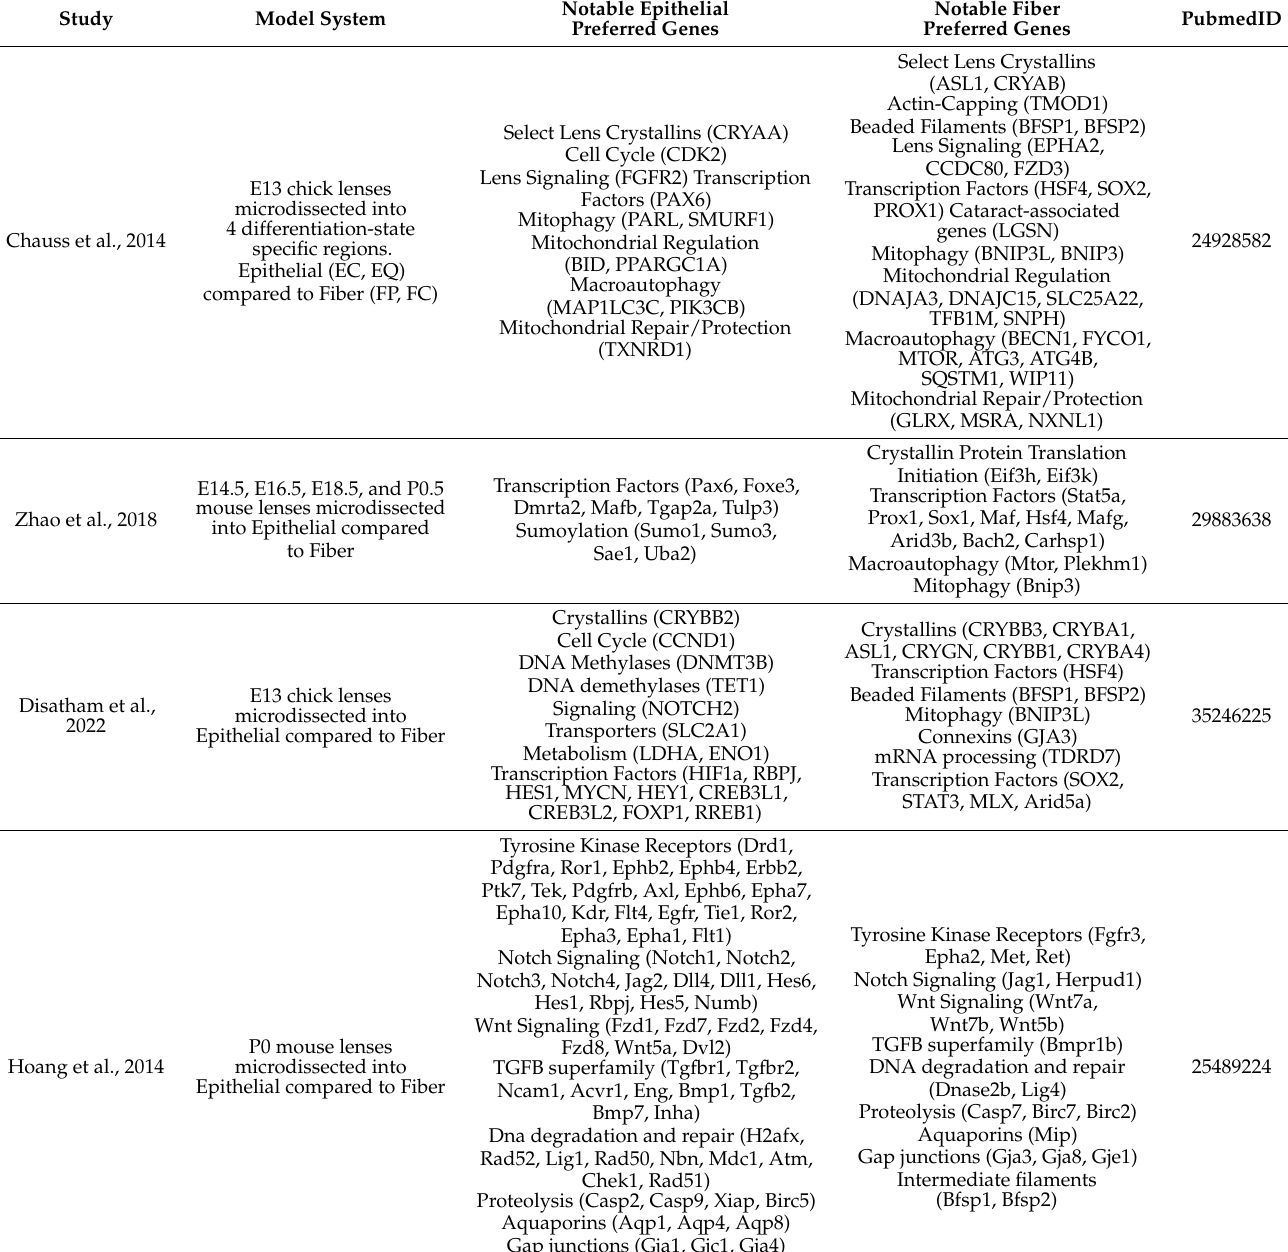
Table 1. Epithelial and fiber cell preferred genes identified with multiple RNA-seq studies in chicken and mice